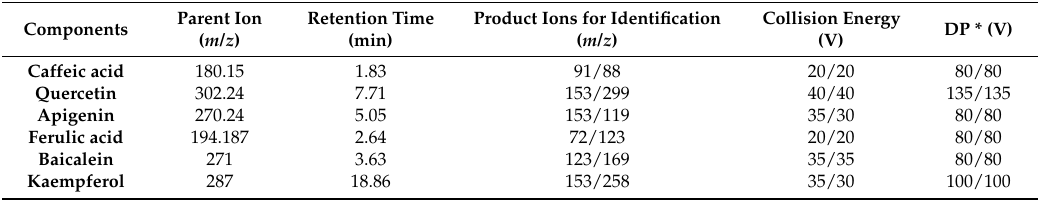
Table 2. The optimized MS parameters for determination of the six components in AR using